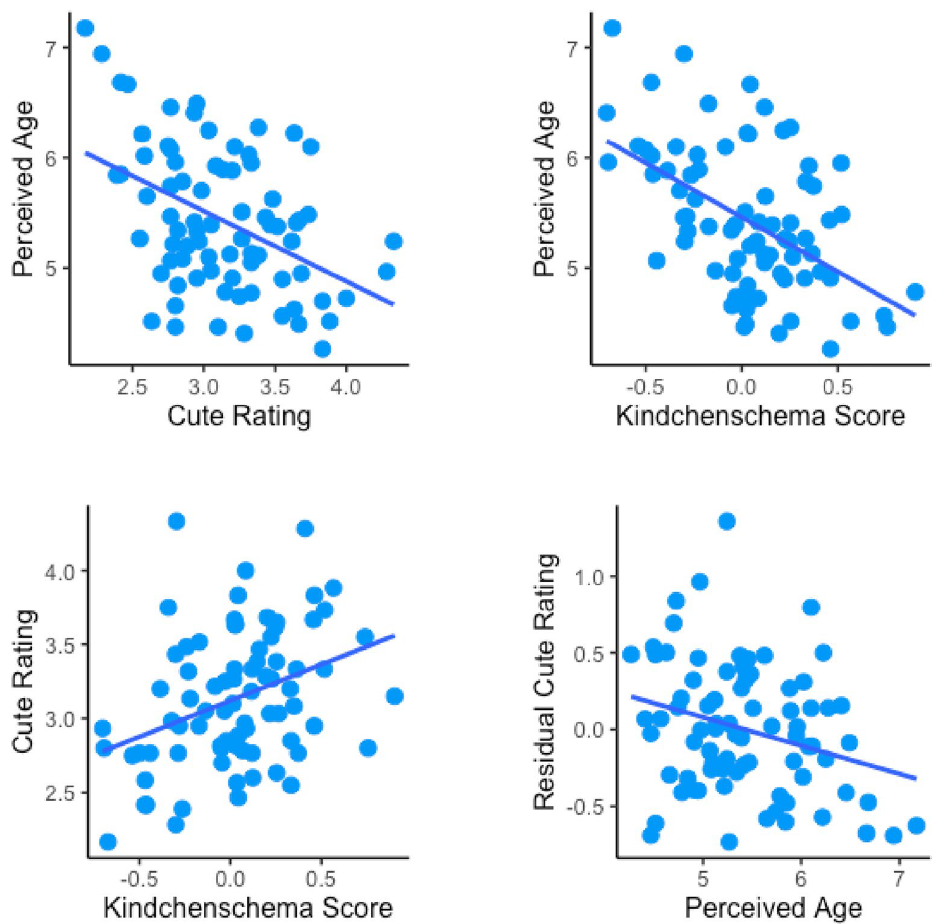
Figure 2. Results of Experiment 1. ( Top panel and Lower Left ) Perceived age, cute ratings, and kinchenschema scores for face images were correlated. ( Lower Right ) Cute ratings remained correlated with perceived age after partialling out variance related to kindchenschema scores. Plots show image